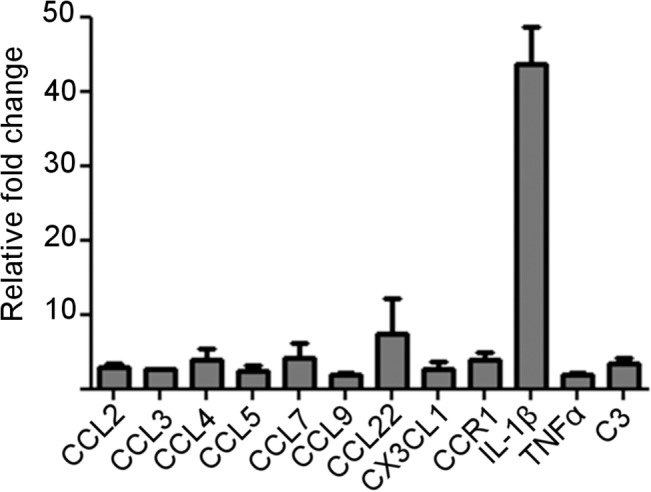
PCR array for inflammatory cytokines, chemokines and receptors on RAW 264.7 macrophages treated with or without S100B (2 μM for 6 h).Graph shows relative fold change in response to S100B for those genes with >2 fold change after S100B treatment (2-ΔΔCT). Fold regulation normalised to GAPDH. Mean of two individual experiments each with 3 pooled samples.